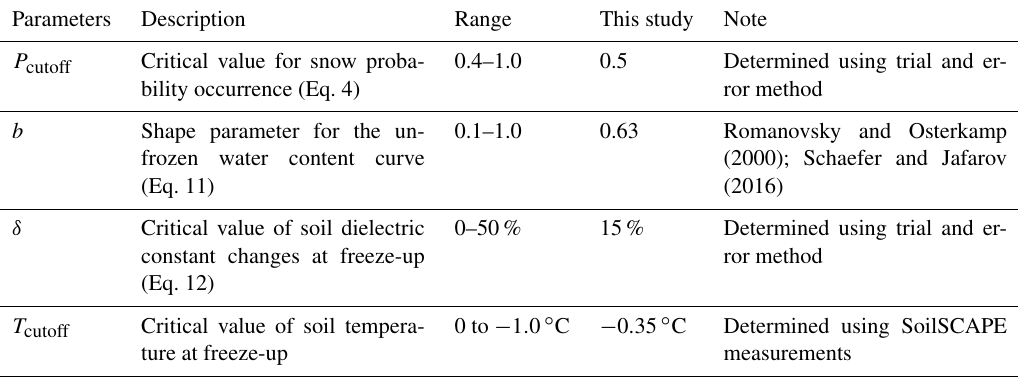
Table 1. Key model parameters used in this study.